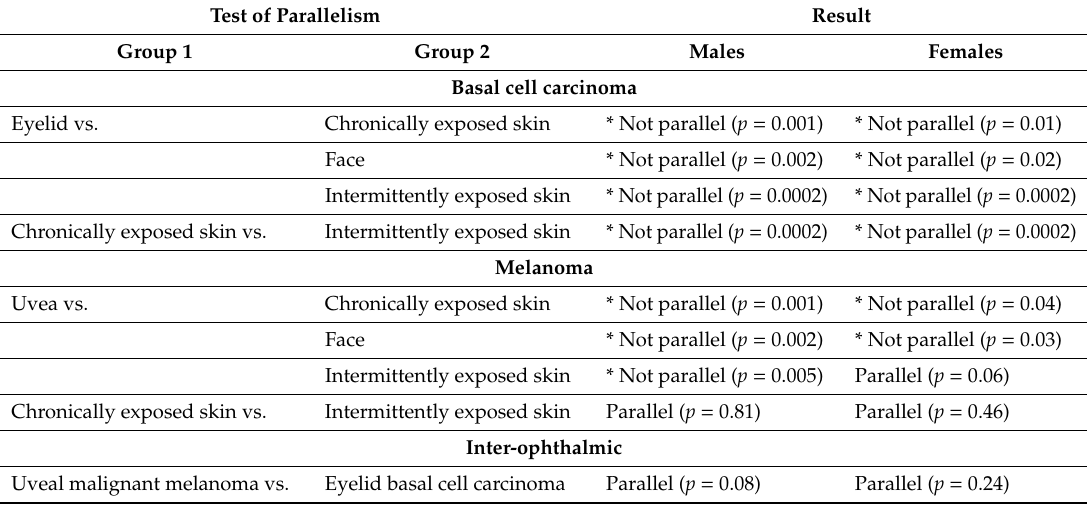
Table 3. Test of parallelism between anatomic groupings for basal cell carcinoma and melanoma,